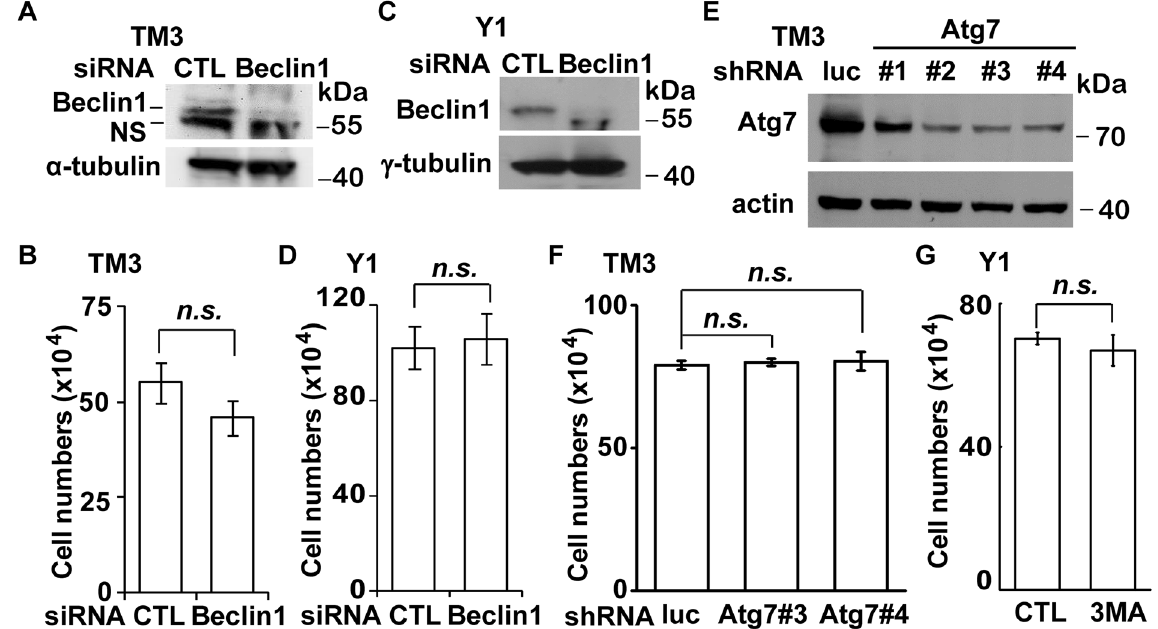
Figure 2. Autophagy is dispensability for steroidogenic cell growth. ( A – D ) Depletion of Beclin 1 does not affect steroidogenic cell growth. ( A and C ) Whole cell extracts of siRNA against Beclin1-treated TM3 ( A ) or Y1 ( C ) cell lines were analyzed by immunoblot with antibodies against Beclin1, α -tubulin, and γ -tubulin. NS: non-specific signal. ( B and D ) Quantitation of cell numbers of Beclin1 depleted TM3 ( B ) or Y1 ( D ) cell lines. ( E , F ) Depletion of Atg7 does not affect TM3 cell growth. ( E ) Whole cell extracts of lentivirus containing shRNA against Atg7 (shAtg7#1-4)-infected TM3 cell line were analyzed by immunoblot with antibodies against Atg7 and actin. ( F ) Quantitation of cell numbers of Atg7 depleted TM3 cell line. ( G ) Treatment of cells with autophagic inhibitor 3MA (2 mM) does not affect cell growth. Quantitation of cell numbers of 3MA-treated Y1 cells. These results are mean + / − SD from three independent experiments. n.s.: no